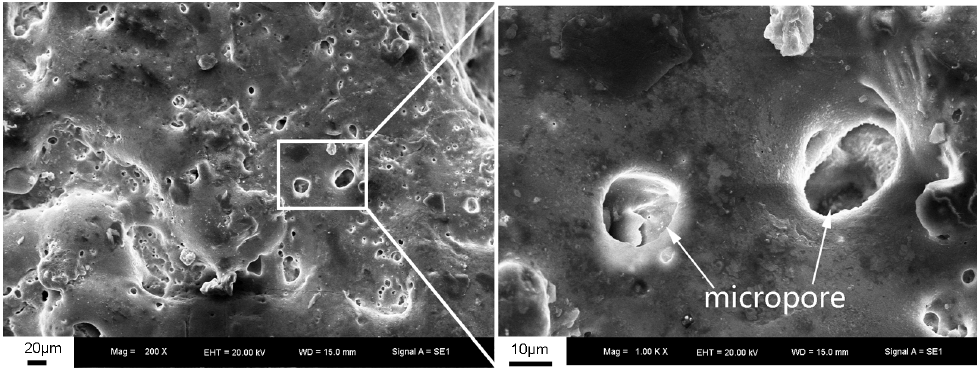
Figure 2. SEM (scanning electron microscopy) images of the surface of the PEO coating.